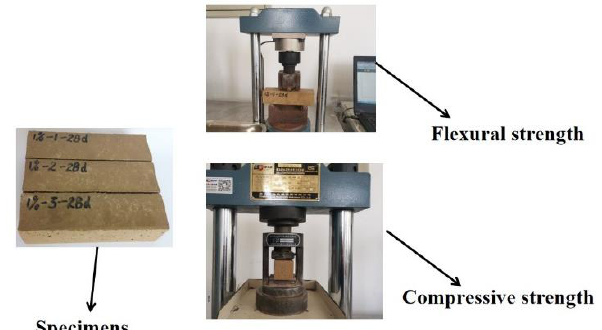
Figure 1. The flexural and compressive strengths of phosphate cement-based materials.